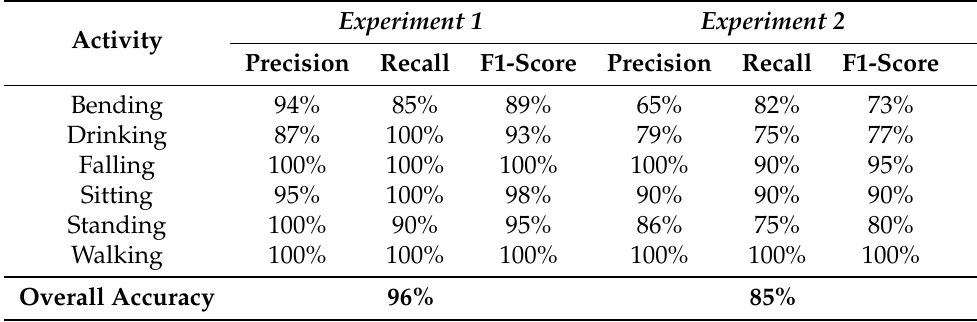
Table 1. Experiments 1 and 2 classification report of six distinct activities trained by residual neural